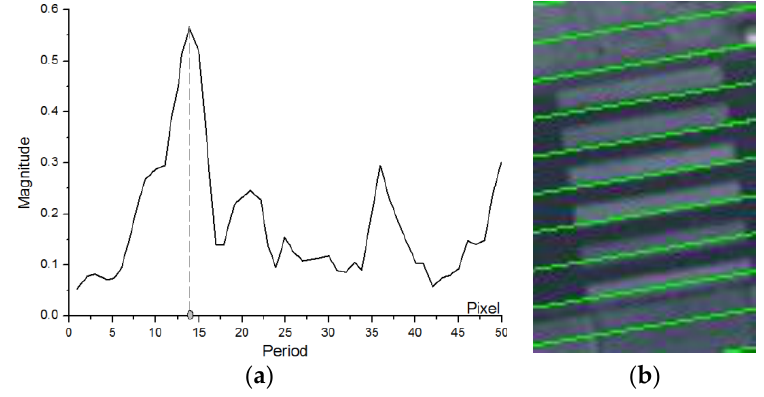
Figure 12. Determining the repetitive pattern of zebra crossing. ( a ) Frequency distribution on the main direction of zebra crossing; ( b ) Parallel lines generated representing the spatial period.